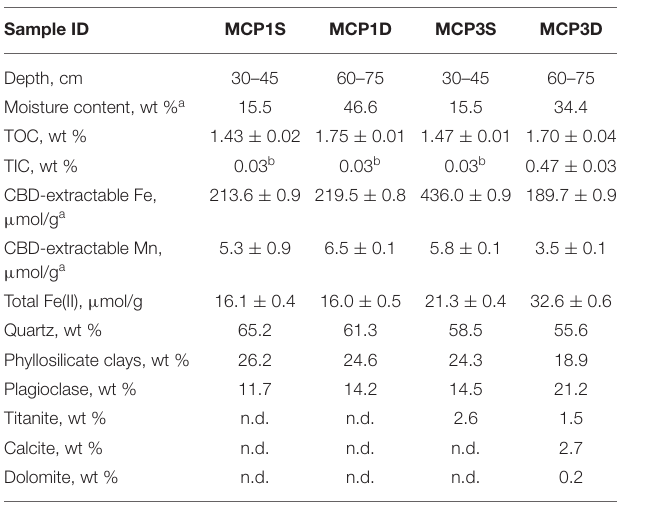
TABLE 2 | Characterization of hyporheic sediment samples.